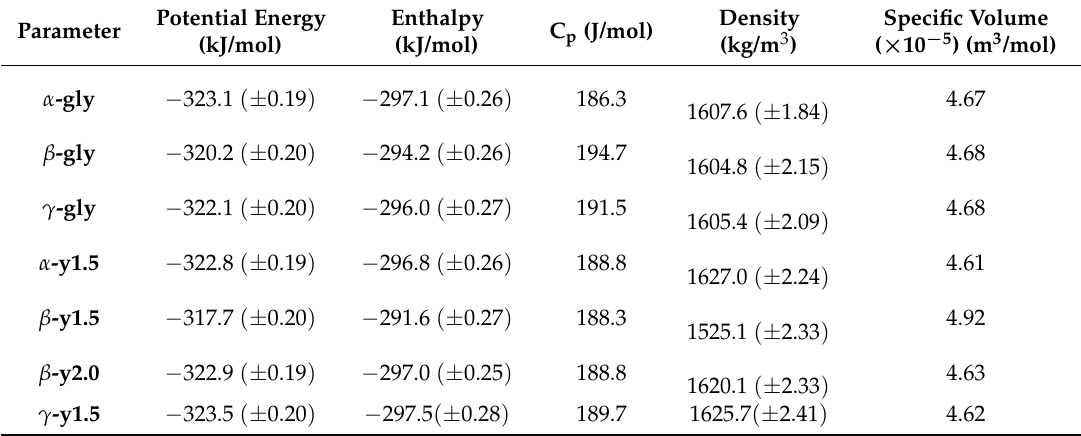
Table 2. Properties of known and new polymorphs of glycine at 1 bar and 298 K, obtained by subjecting the known polymorphs to an e-field in the y-direction with V = 1.5 V/nm. Properties of β -y2.0 are also included. Values in parentheses are root mean square